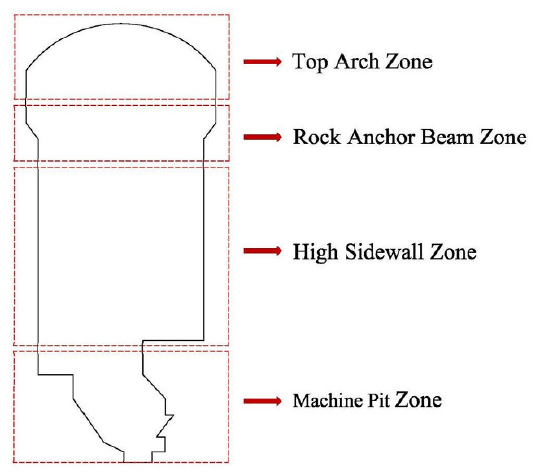
Figure 2. Four excavation zones of the main powerhouse.